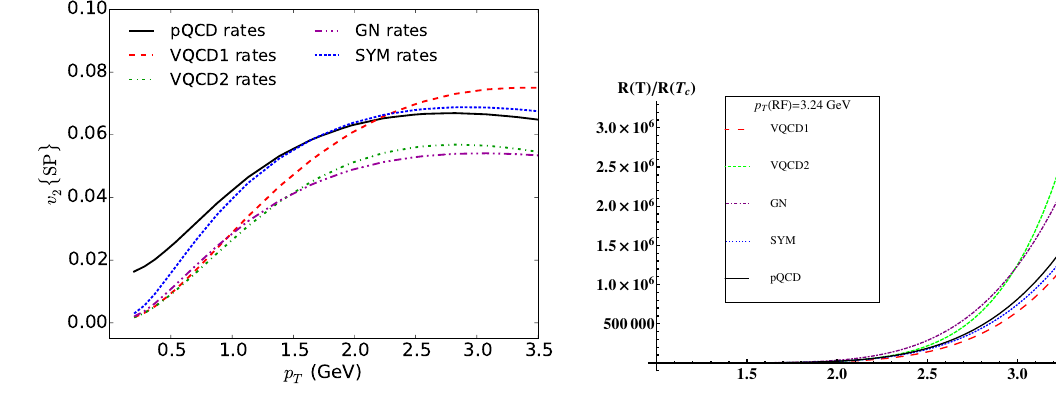
Figure 8 . (Color online) Thermal QGP photon v 2 ( p T ) using di(cid:11)erent emission rates in the QGP phase in 0{40% Pb+Pb collisions at 2.76 A TeV.